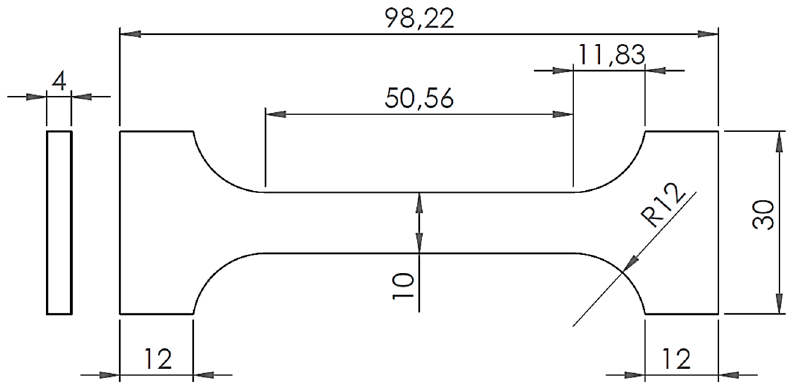
Figure 1. Test piece of solder for static tensile test. Unit: mm.